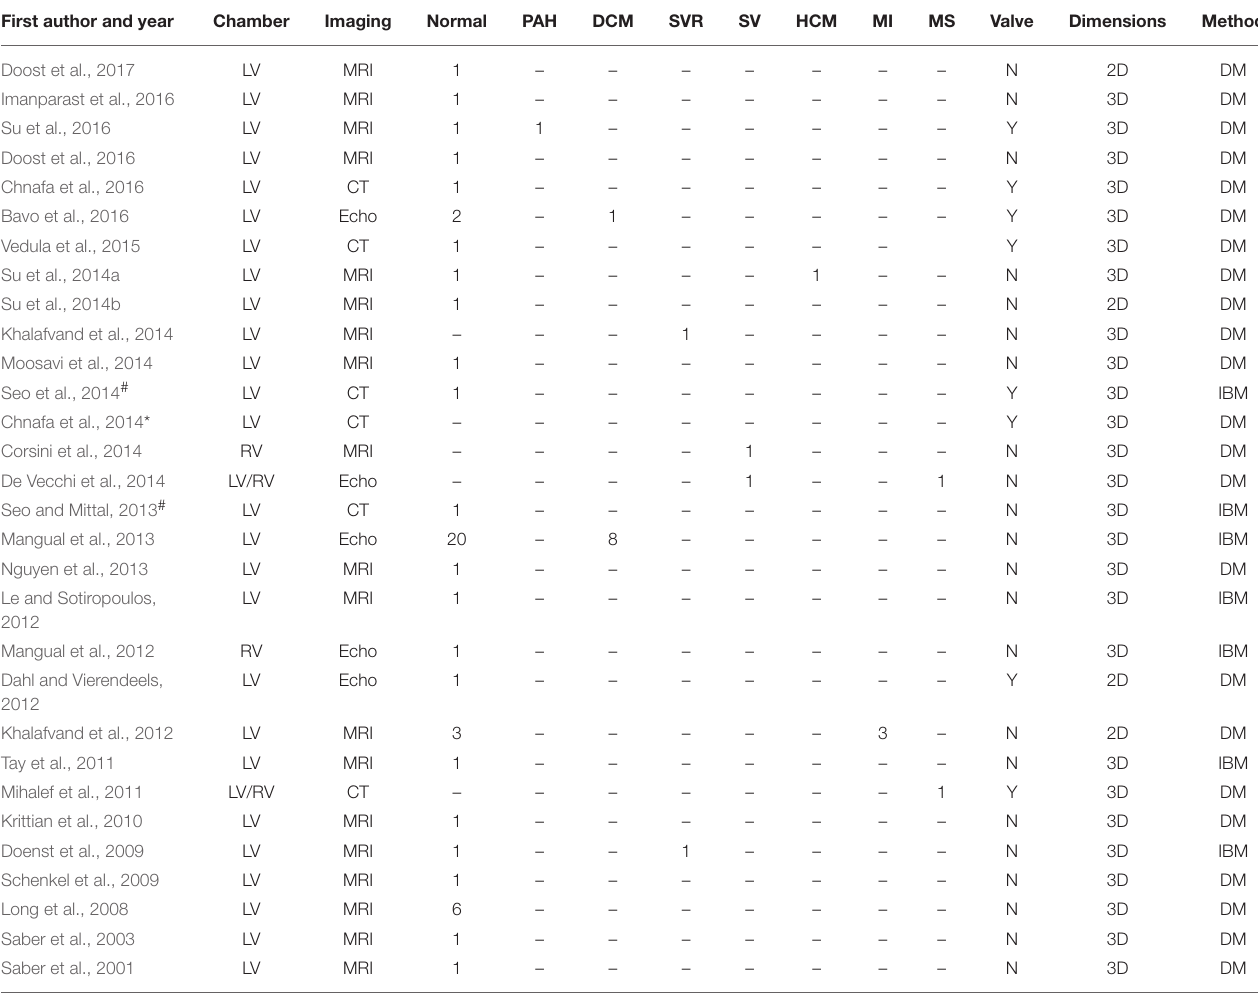
TABLE 4 | Published patient-specific CFD simulations of heart